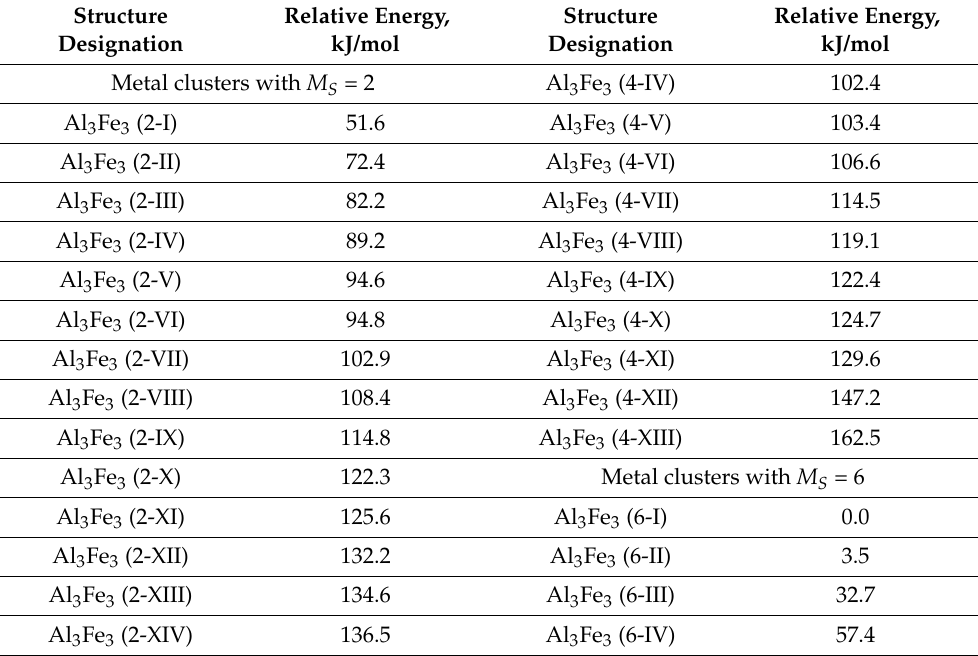
Table 5. Relative energies and spin multiplicities of the ground states of various structural isomers of metal clusters of Al 3 Fe 3